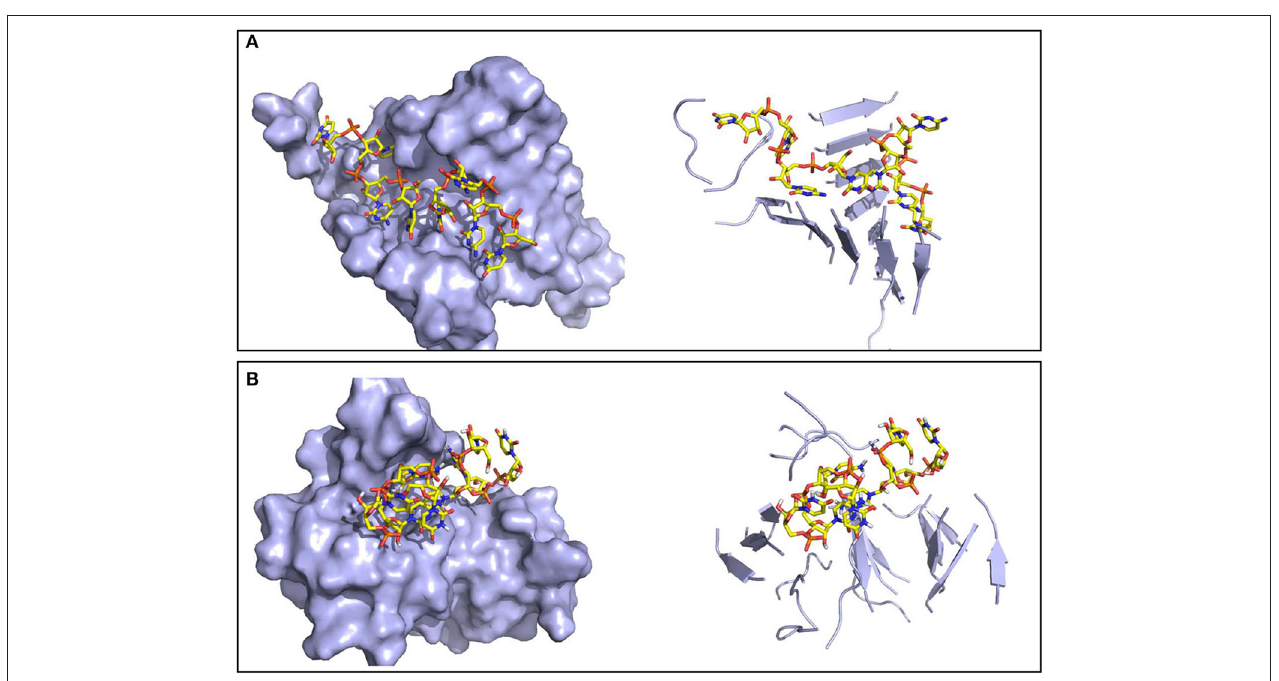
FIGURE 6 | Representative structures of the oligomers formed by the RNA tetramer and peptide sequences. Surface (left) and secondary structure (right) representations of (A) the ordered oligomer formed with SNQNNF, and (B) the smaller and less organized oligomer formed with GYMLGS.